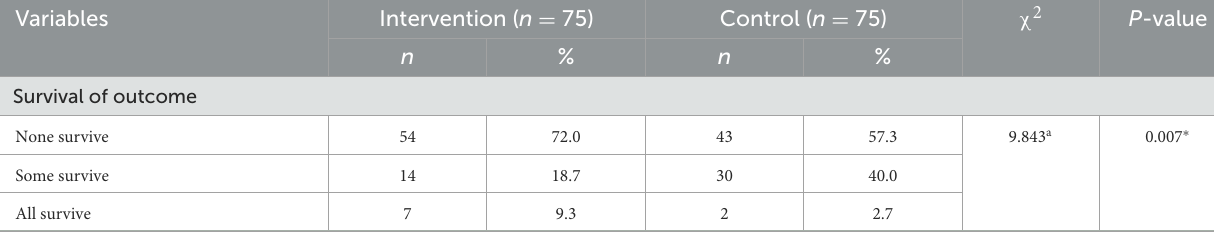
good skills than those at the pretest (baseline) respectively, however, nurses at 6 months had lower probability of having good skills than at baseline (AOR = 0.310, 95%CI: 0.142, 0.677, p = 0.003). By looking into the interaction between time and group, the intervention group at posttest had lower probability of having good skills than the control group at baseline (AOR = 0.091, 95%